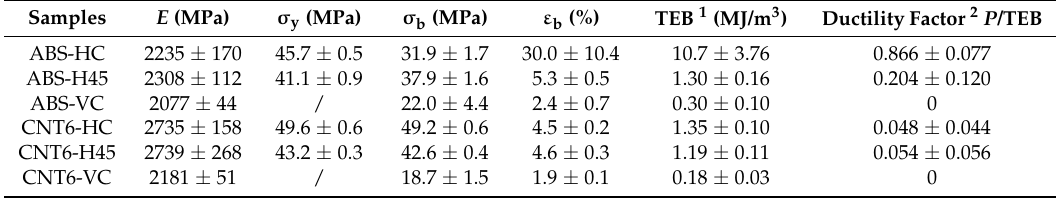
Table 6. Quasi-static tensile properties of ABS and its nanocomposite of FDM